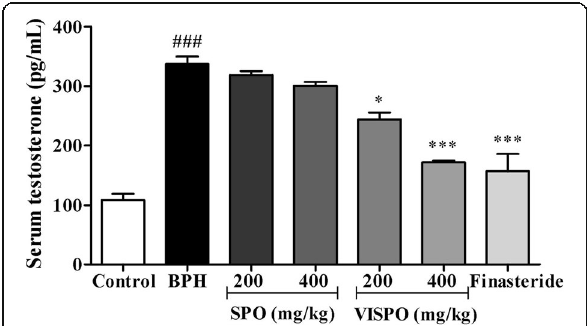
Fig. 3 Effect of SPO and VISPO on serum testosterone level. The data were analyzed by one way ANOVA followed by Dunnet ’ s t-test.